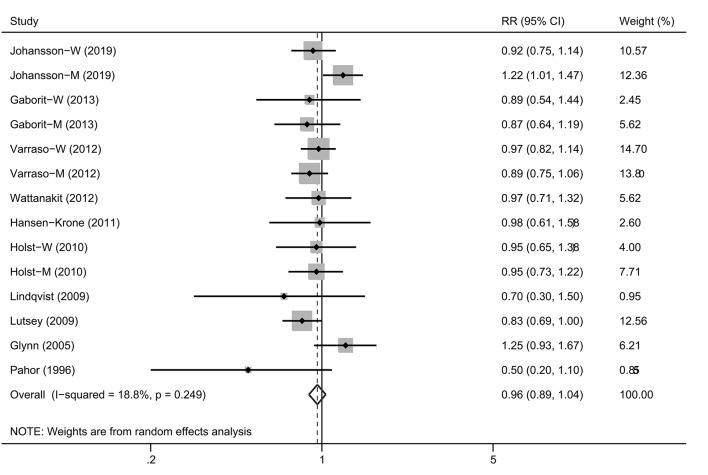
A forest plot showing risk estimates estimating the association between alcohol consumption and venous thromboembolism risk.